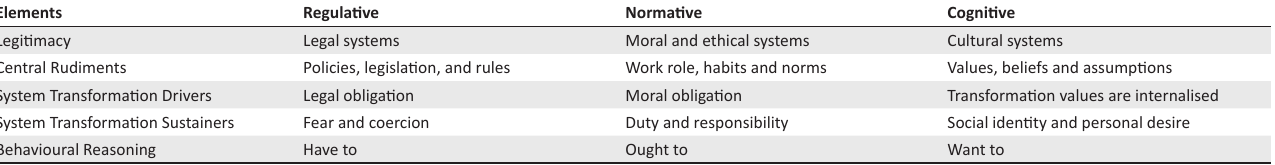
FIGURE 1: The sustainable livelihoods TABLE 1: Comparison between regulative, normative and cultural-cognitive elements of Institutional Theory. Elements